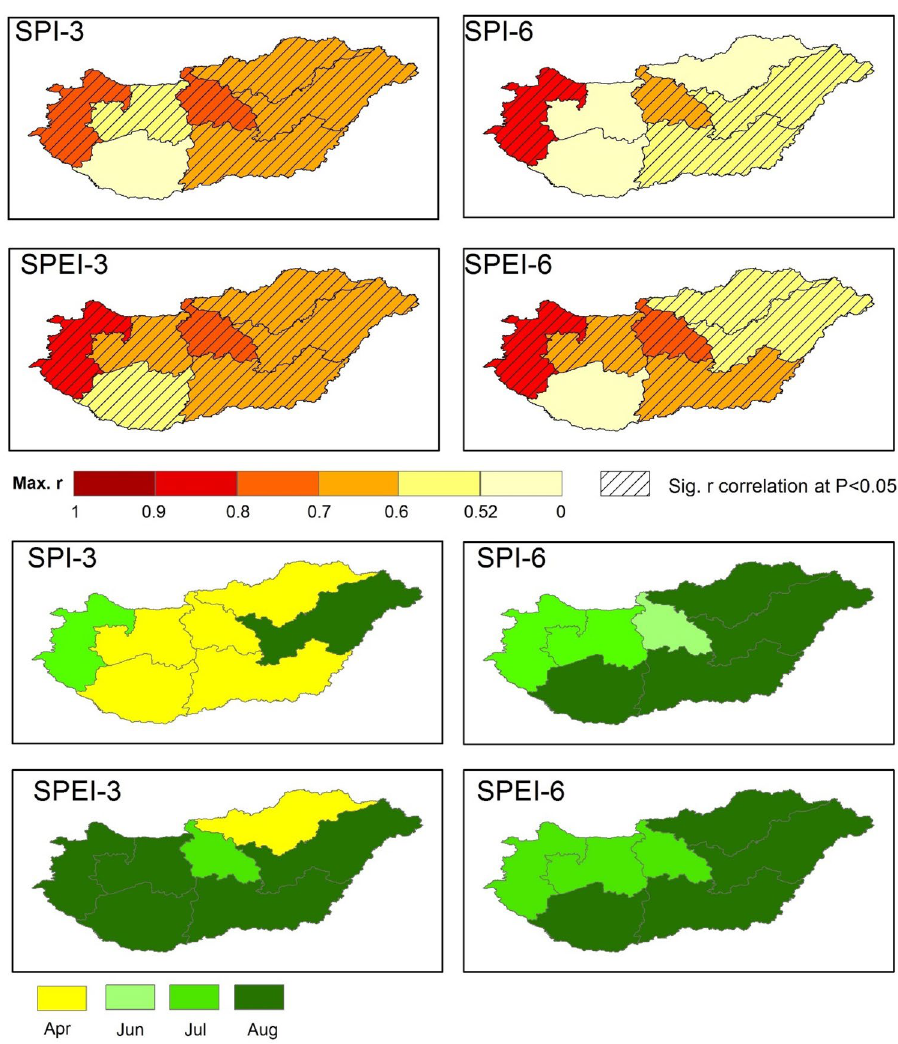
Figure 12. Spatial distribution of maximum correlation between drought indices (SPI-3, SPEI-3, SPI-6, SPEI-6) and SYRS for wheat across Hungary (2000–2010) (upper figures), the corresponding month where the maximum correlation is occurred during the growing cycle (lower figures) (maps were generated using ArcGIS 10.5 (https:// www. esri. com/ en- us/ about/ about- esri/ overv